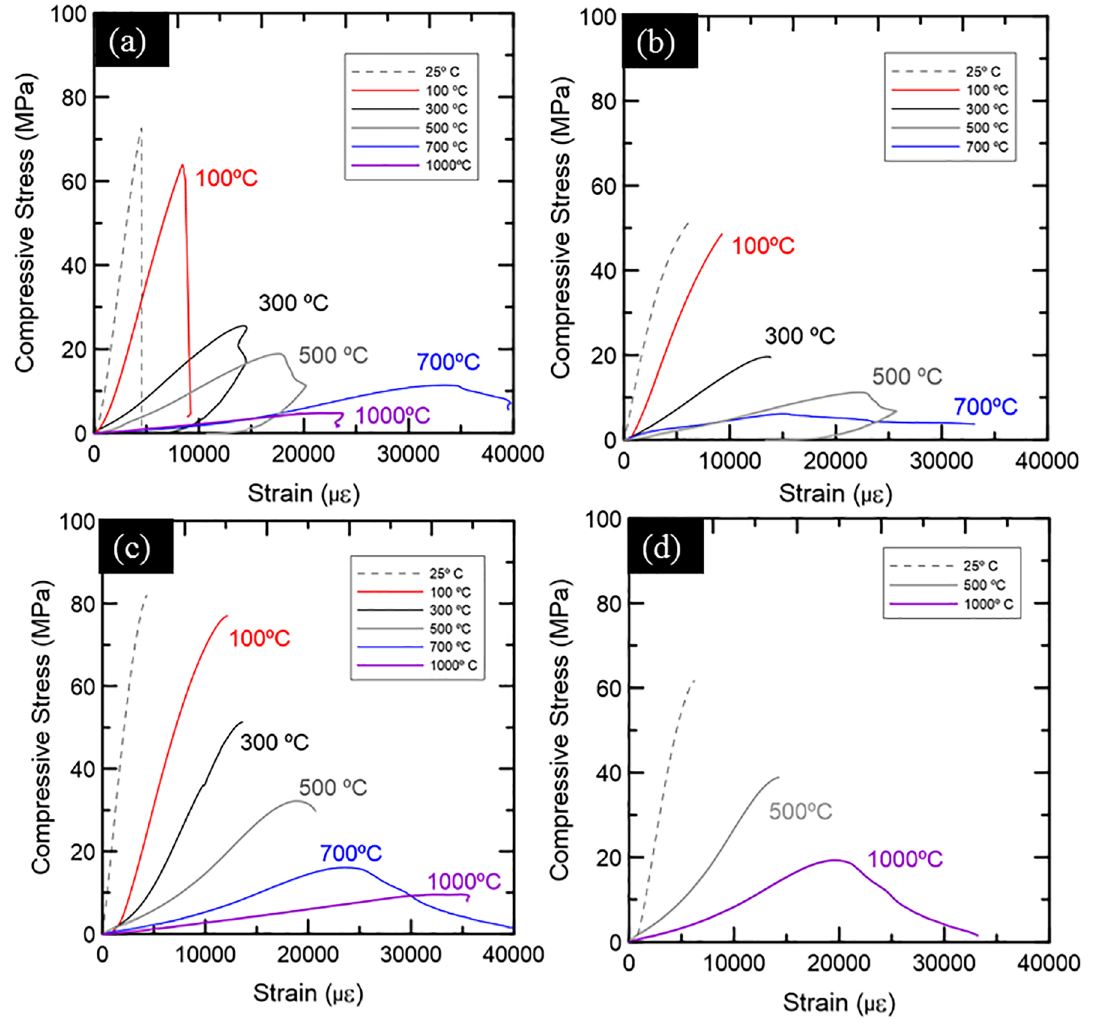
Figure 6. Influence of elevated temperatures on the compressive behavior of (a) 100MK, (b) 80MK20SF, (c) 60MK40BFS, and (d) 100MK + CHA.